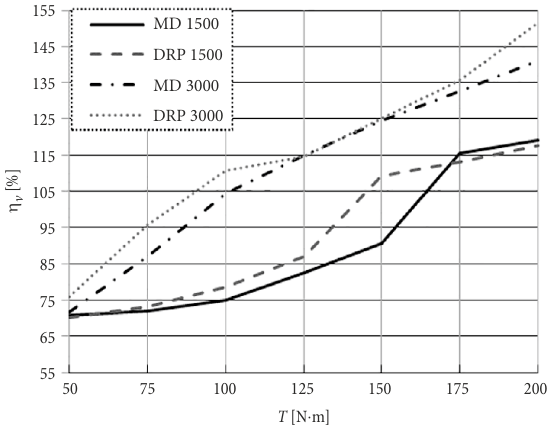
Figure 13. Volumetric efficiency η v vs engine load for MD and DRP at 1500 rpm and 3000 rpm